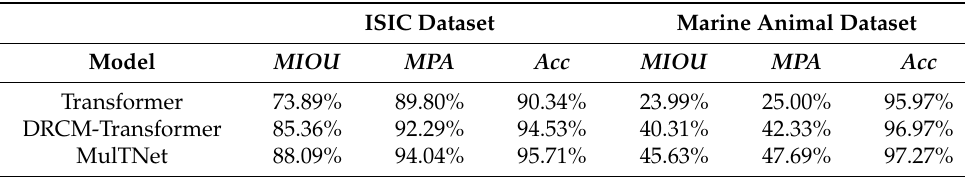
Table 6. Ablation